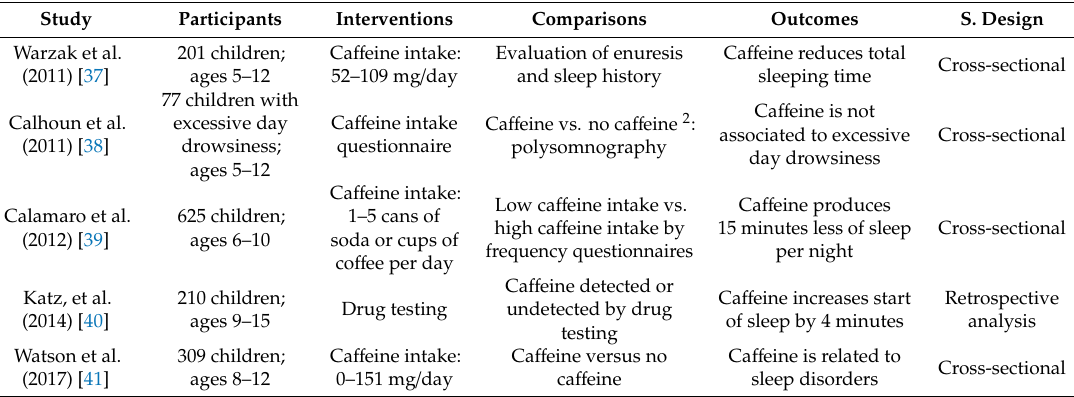
Table 7. Description of analyzed studies on sleep disorders, according to the PICOS 1